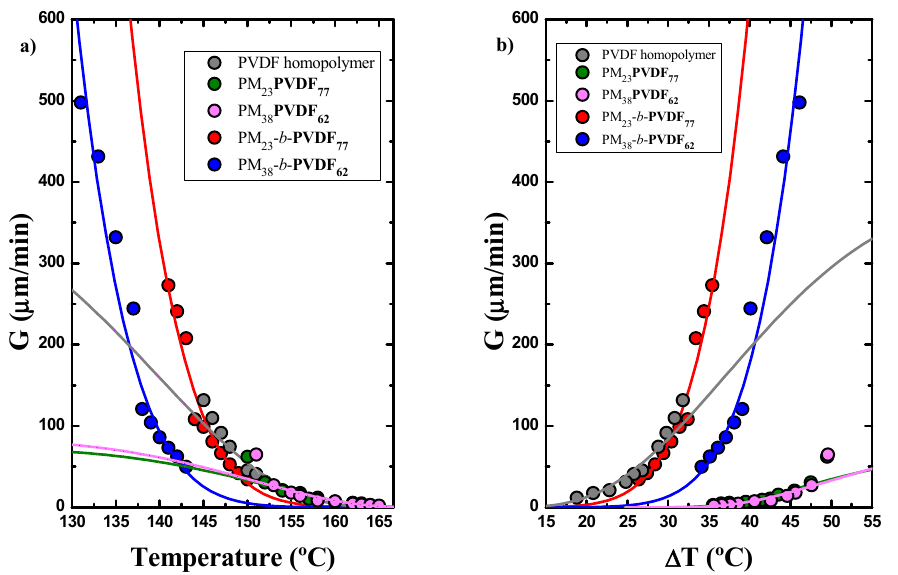
Figure 9. ( a ) Spherulitic growth rates determined by PLOM for homopolymer PVDF, the PVDF block of the diblock copolymers, and the PVDF phase within the blends studied and ( b ) spherulitic growth rates as a function of supercooling. The solid lines are the fits to the Lauritzen–Hoffman (LH) theory.